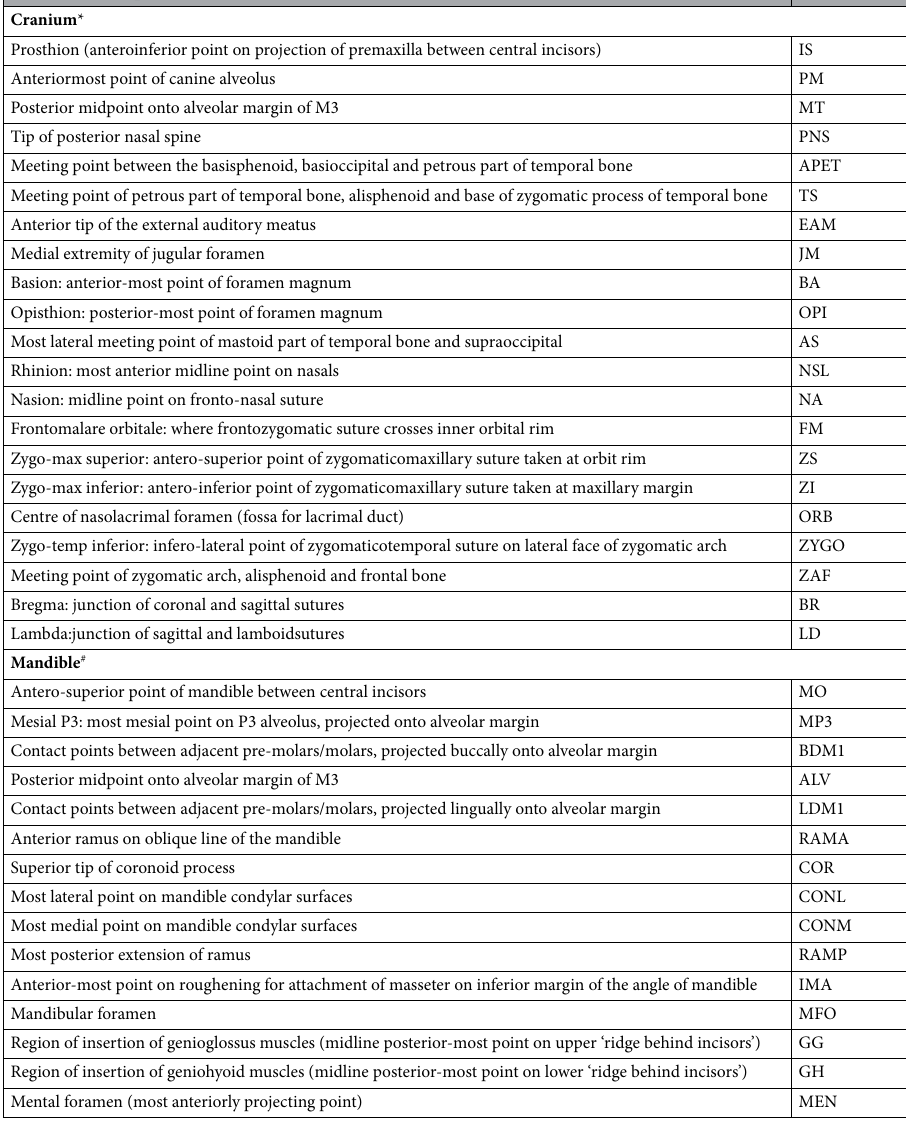
Table 3. Description of landmarks used in this study. *Cranial interlandmark distances were extracted from this list as follows: IS-PM, BR-APET, MT-PNS, IS-NSL, ZAF-FM, PNS-APET, IS-PNS, TS-MT,